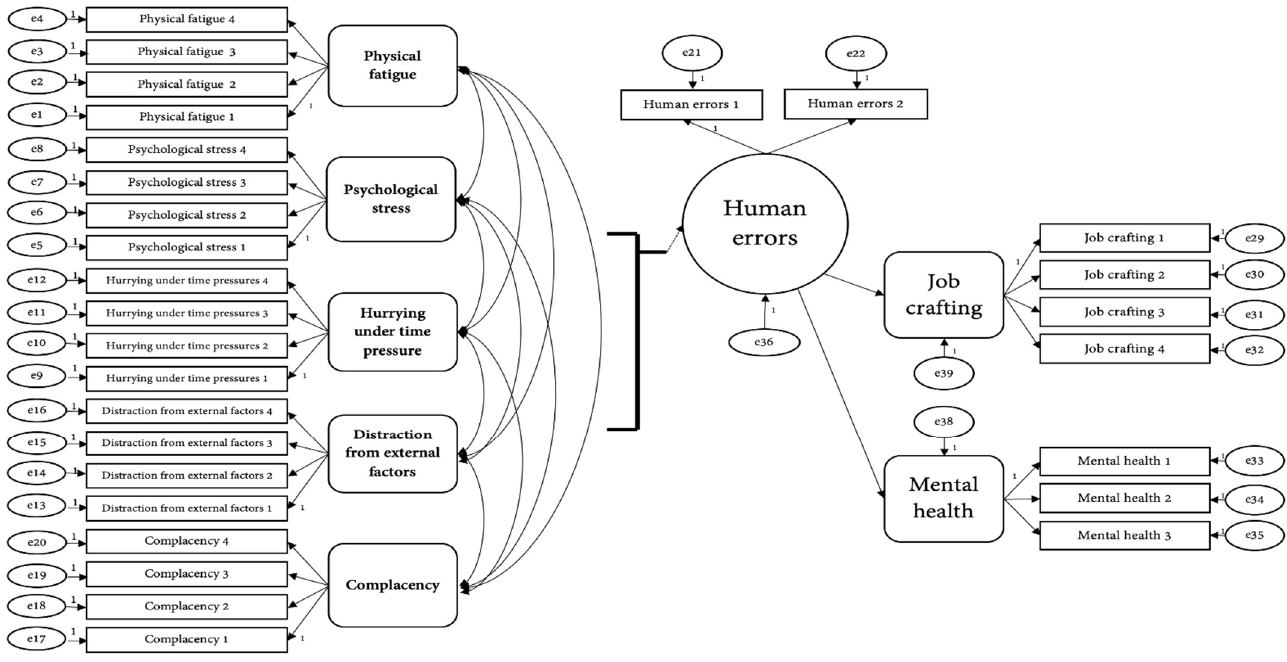
Figure 3. Structural equation model. Table 7. Structural model path